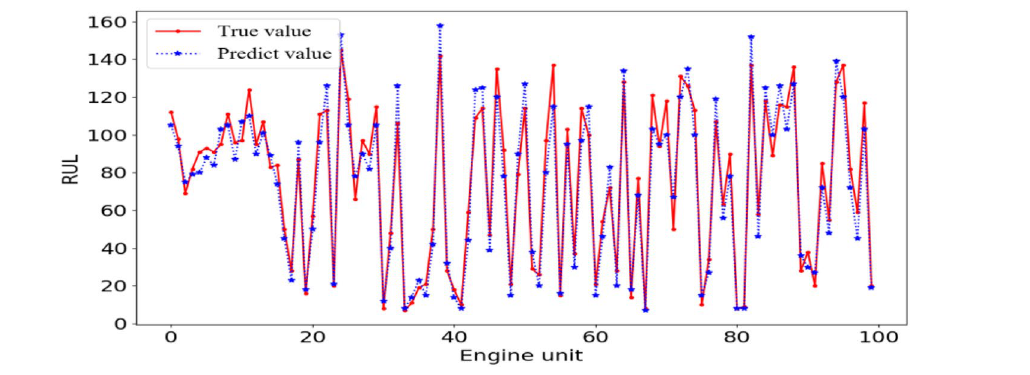
Figure 10. The RUL prediction results of the test